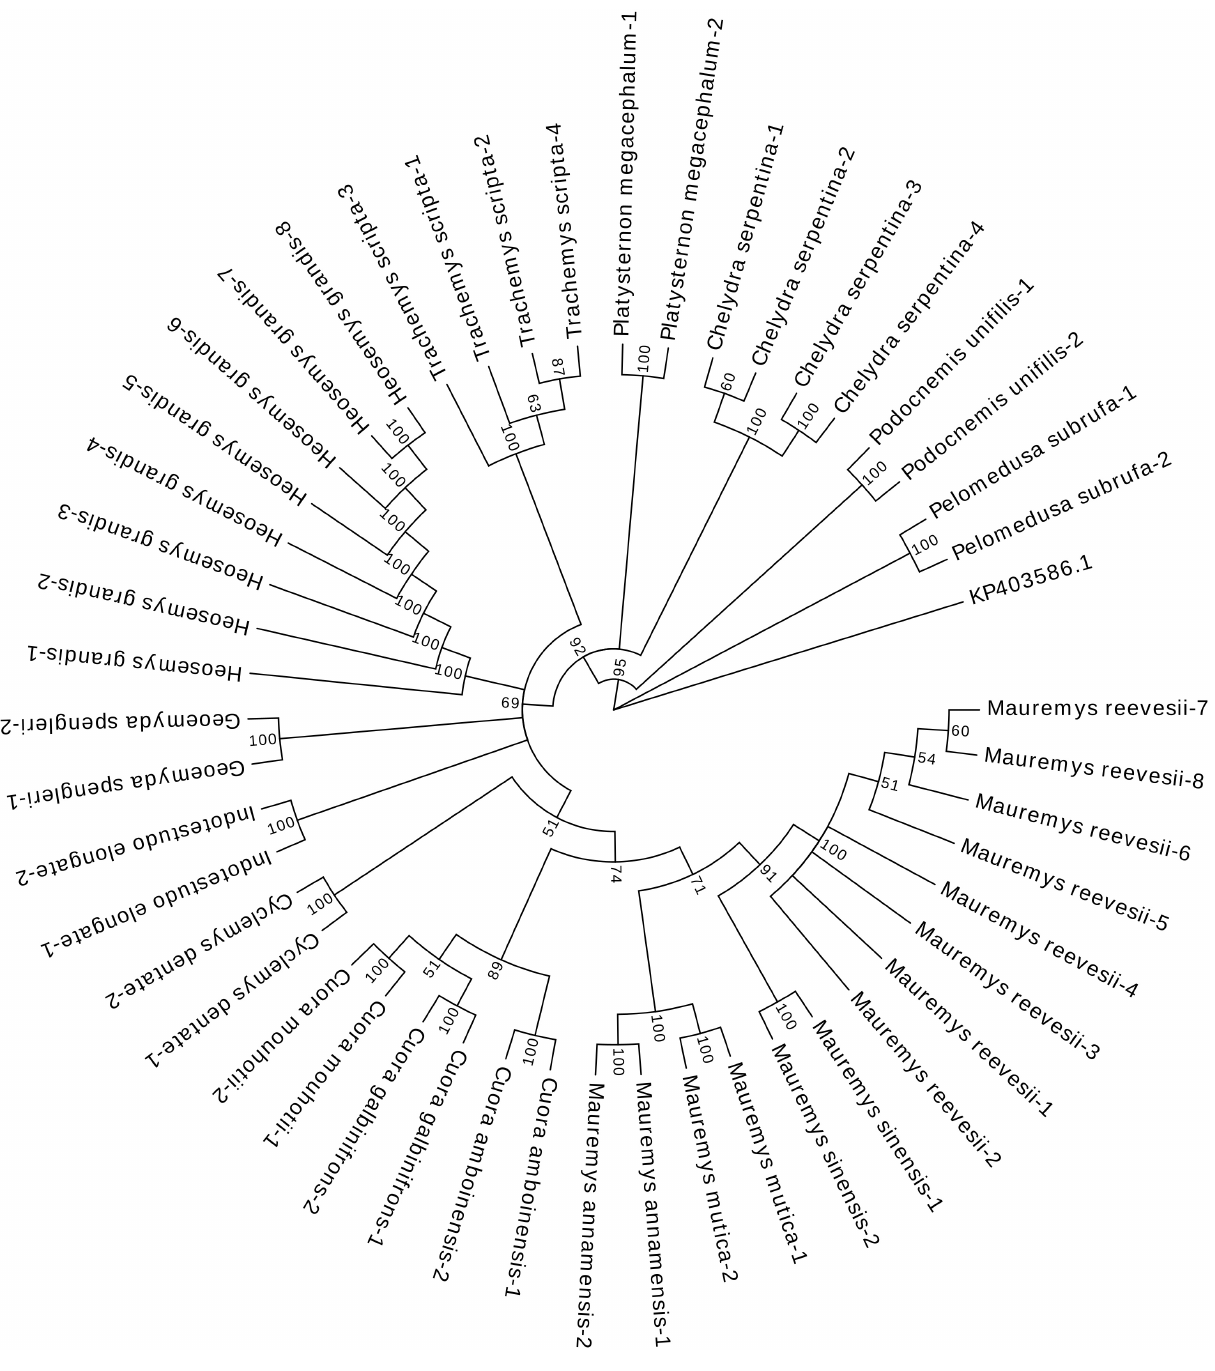
and limitations. Through DNA sequencing, the DNA mini- barcoding identification method can obtain the DNA sequence of a specific location in a sample and properly identify the species of an unknown source sample (Chen et al.,